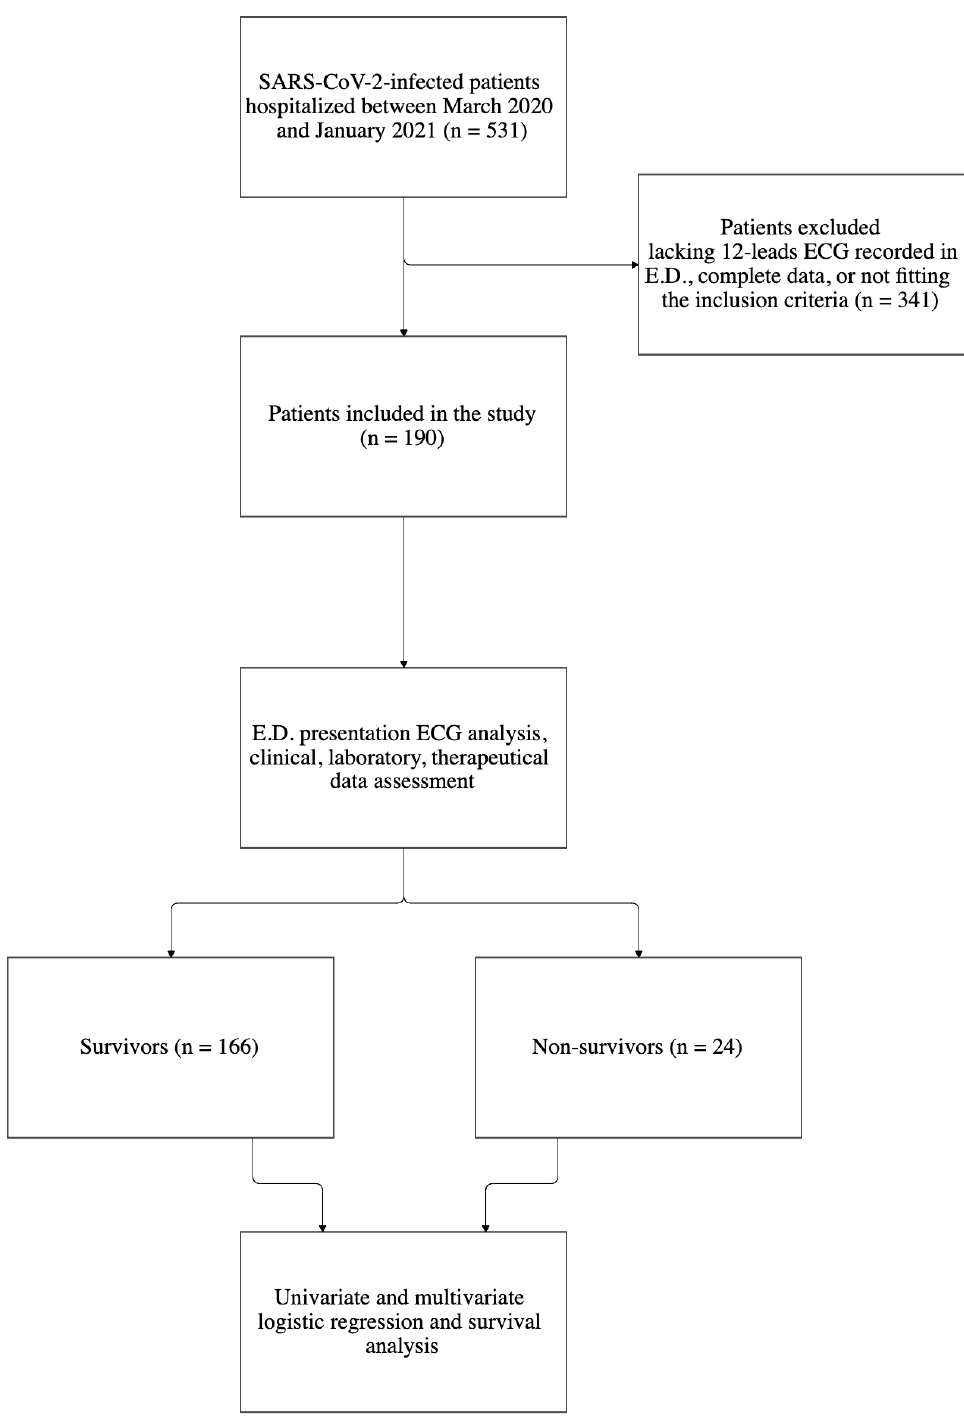
Figure 1. Flow-chart of patients’ recruitment and study course. ED, emergency department; ECG, electrocardiography. ECG,